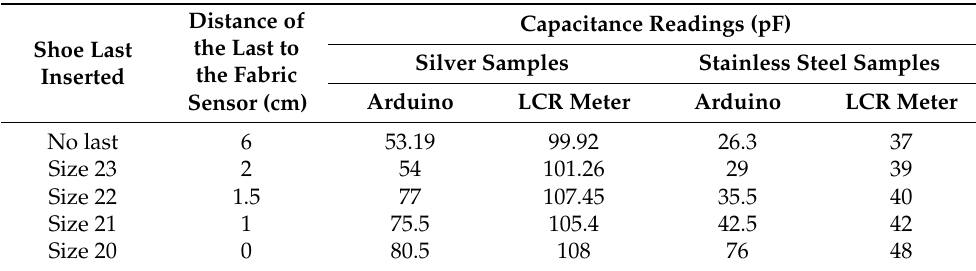
Table 1. Capacitance readings from both knitted textile sensors. Readings derived from LCR meter and Arduino.